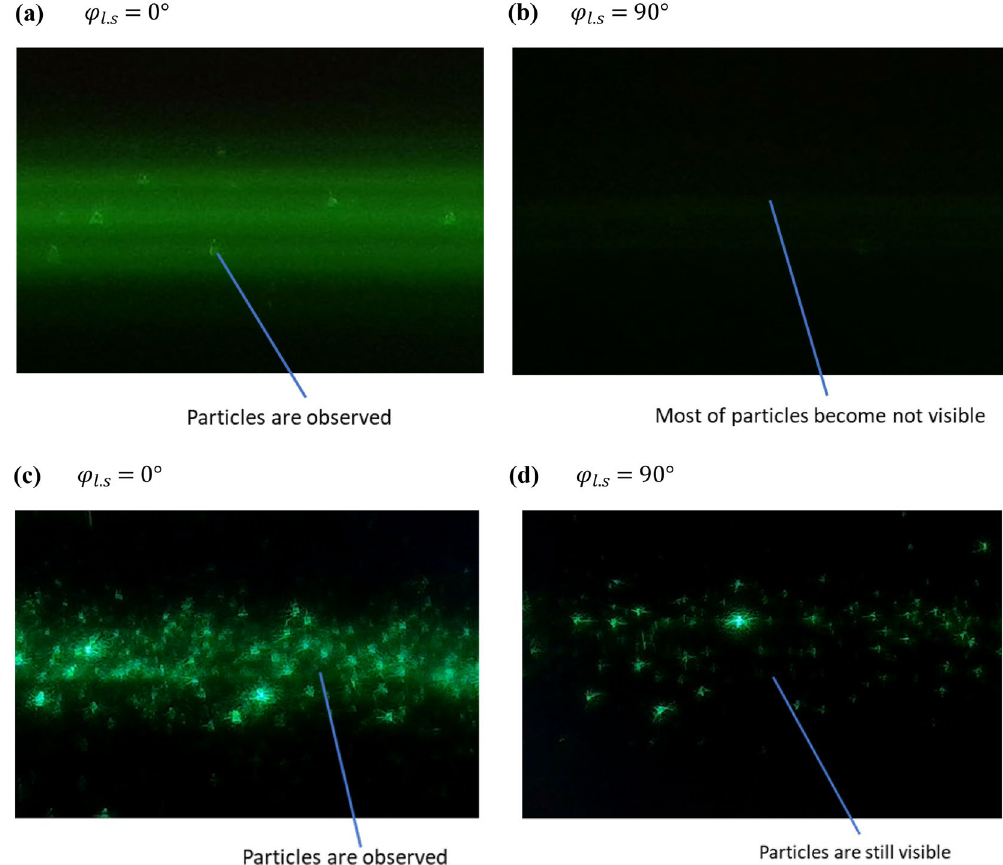
Figure 7. Detection of cleanliness of bottled drinking water using green (532 nm) laser. ( a ) and ( b ) a bottle of drinking water that remains sealed by its manufacturer during the test. ( a ) Using the laser with the polarization 0 angle ϕ l.s ◦ . Suspended particles are observed as large moving dots on top of the light scattering image of = 90 water. ( b ) Using the laser with the polarization angle ϕ l.s ◦ . Most of the suspended particles become not = visible. Therefore, the particles in the bottle are mainly the Rayleigh scattering particles, and they must be much smaller than the laser wavelength. ( c ) and ( d ) the bottled drinking water that is tested with a lower sensitivity 0 setting one week after opening and drinking. ( c ) with the polarization angle ϕ l.s ◦ . More particles are = 90 observed. ( d ) with the polarization angle ϕ l.s ◦ . Many particles are still visible. Therefore, the particles in the = open bottle are not Rayleigh scattering particles and must be much larger than the wavelength of the